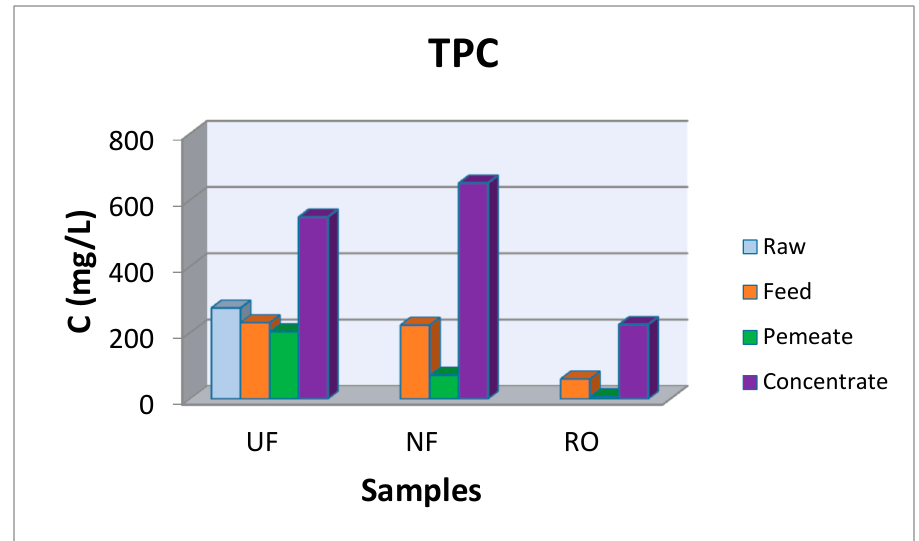
Figure 9. TPC concentration at the raw, feed, permeate and concentrate streams at the UF, NF, and RO membranes.